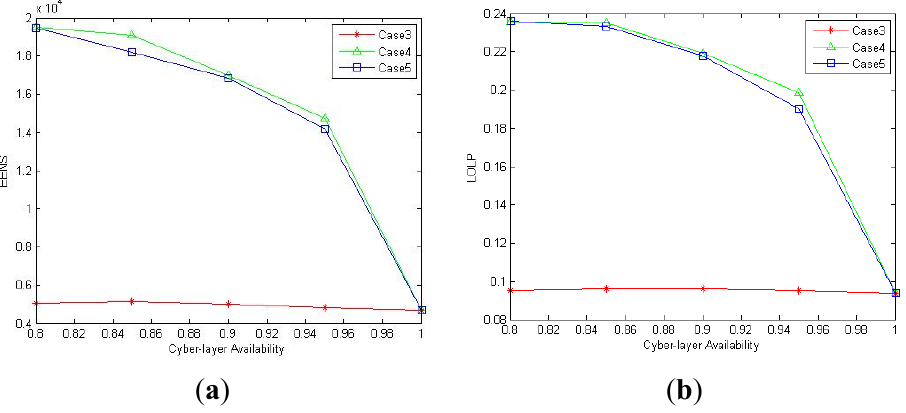
Figure 14. The sensitivity of reliability indices ( a ) versus the availability of cyber layer functions ( b